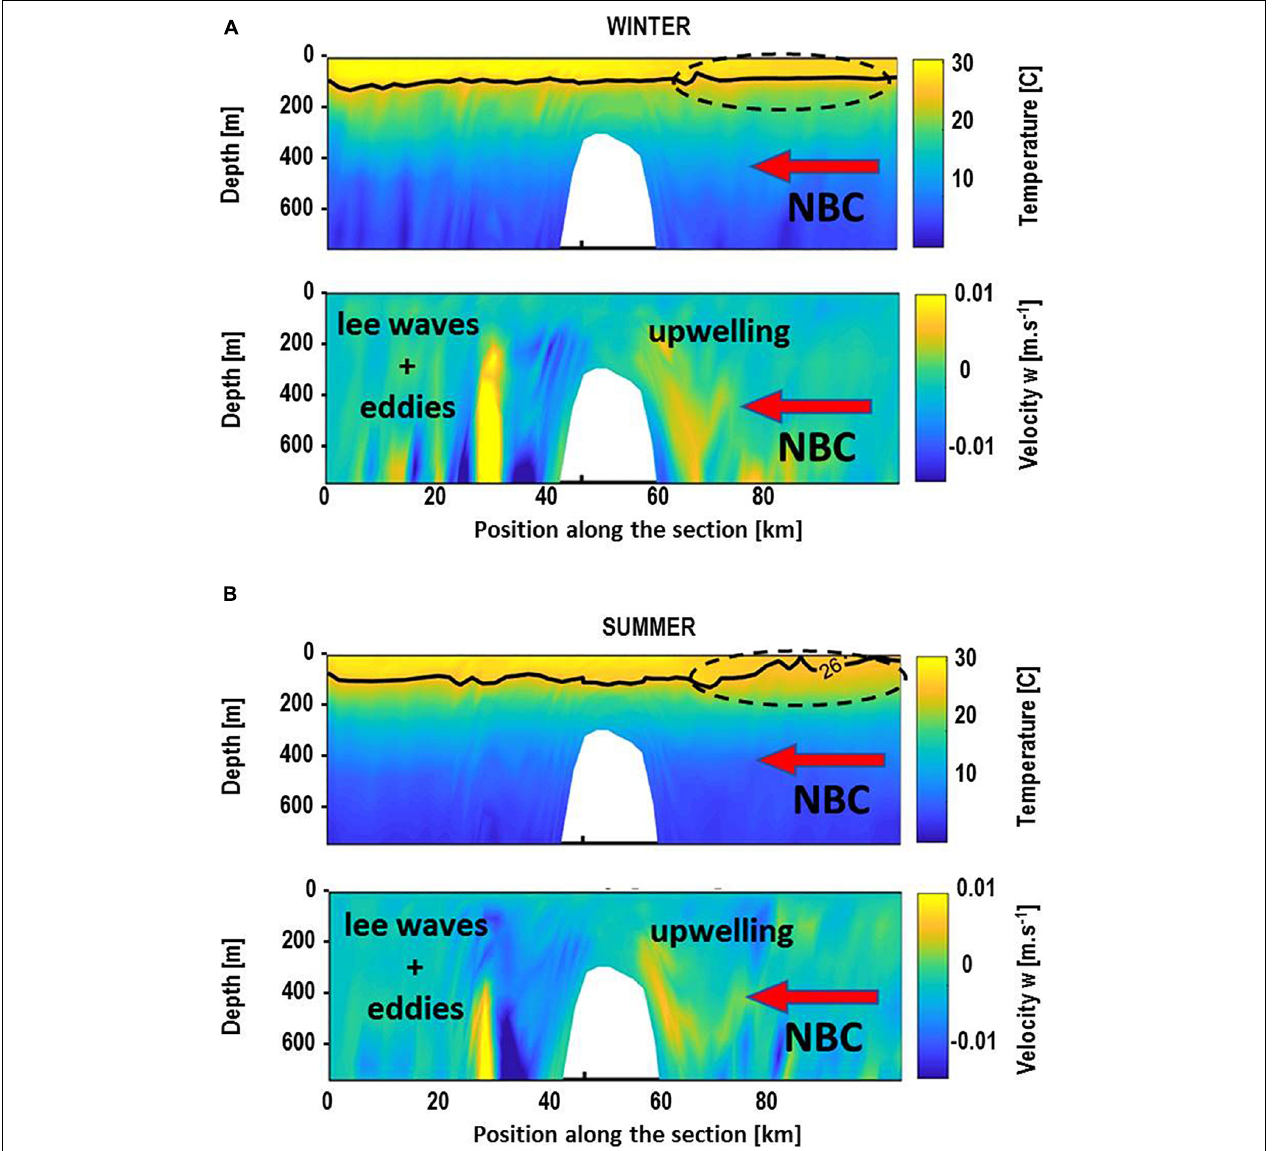
FIGURE 9 | Temperature and w vertical velocity along a section crossing the Aracati Bank area during winter (A) and summer (B) seasons. North Brazil Current (NBC) crosses the bank from the right to the left